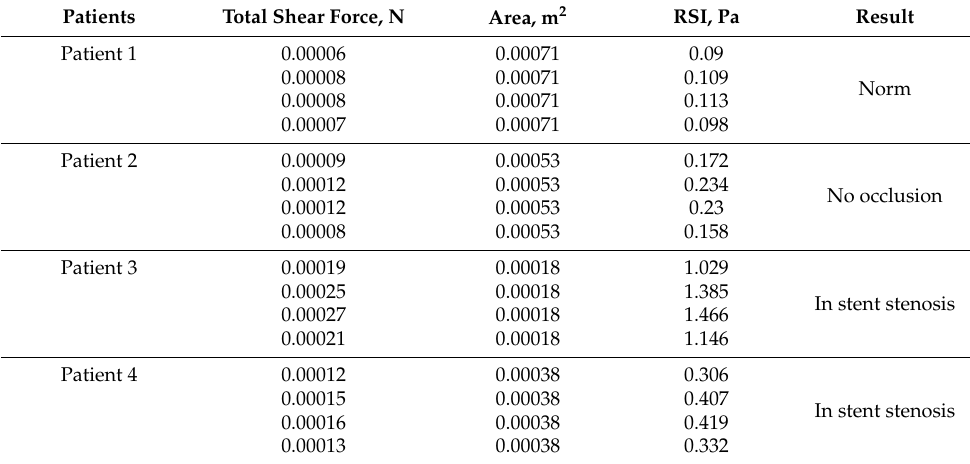
Table 5. Time dependent value of RSI for different clinical outcomes.